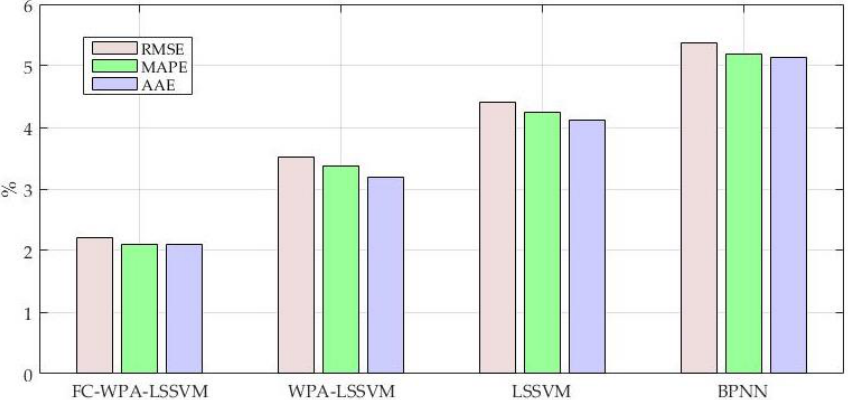
Figure 11. RMSE, MAPE and AAE of the forecasting results (I).